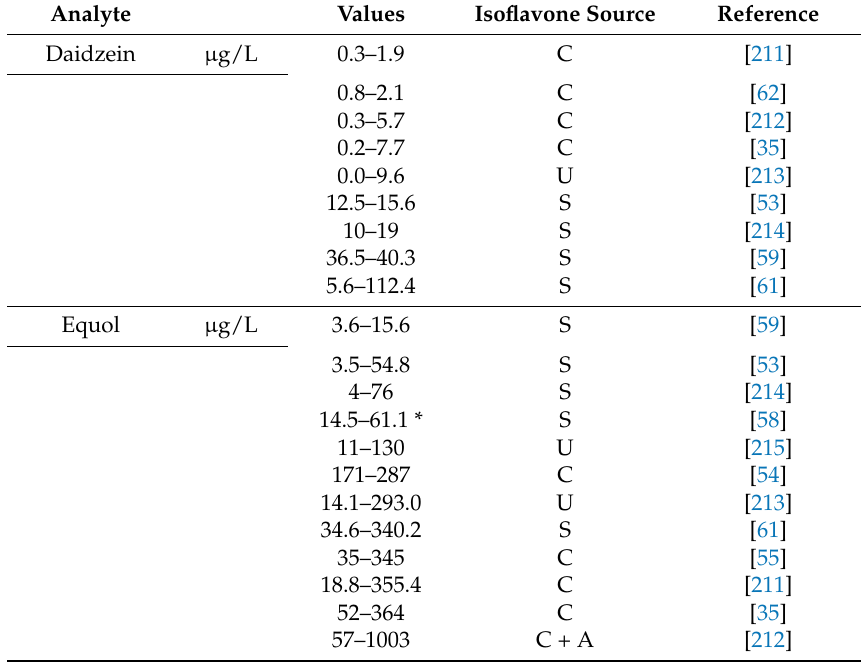
Table 2. Equol and isoflavone concentrations in bovine milk